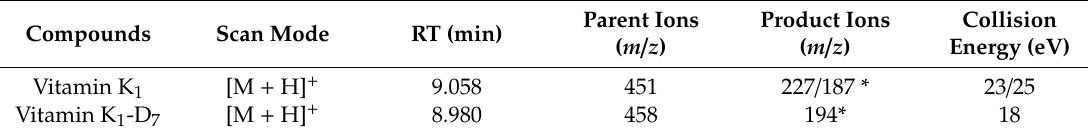
Table 4. MS / MS parameters for analysis of